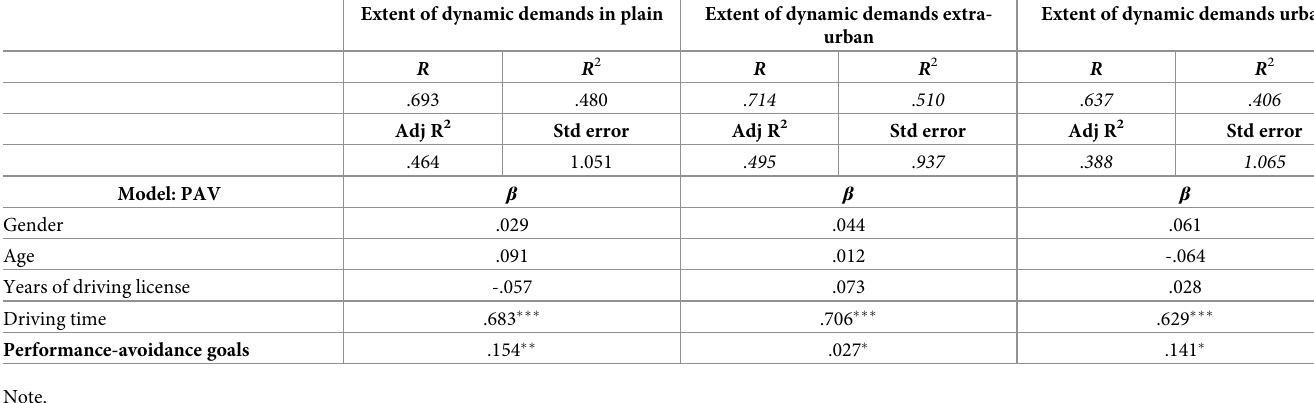
Table 6. Results of the regression analysis for performance-avoidance goals with the road